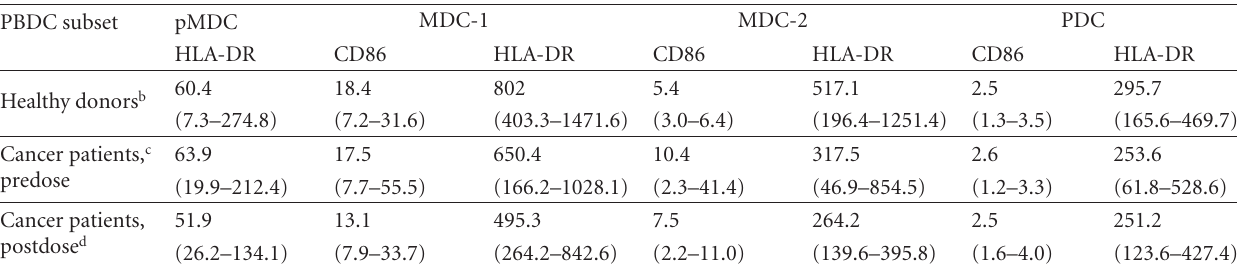
Table 1: Expression of CD86 and HLA-DR on PBDC subsets.